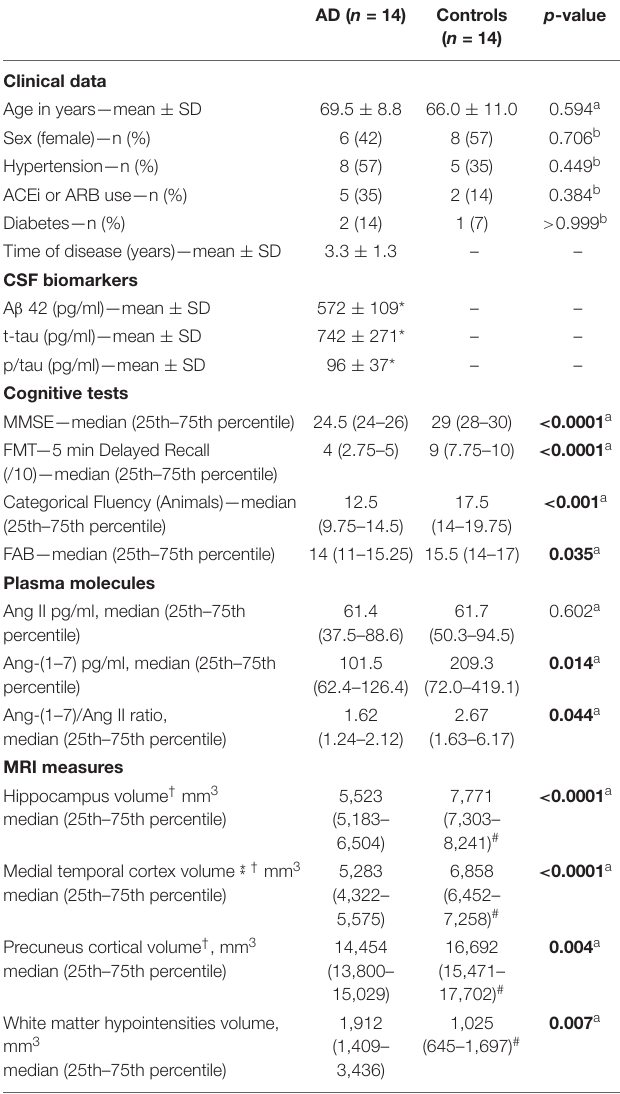
TABLE 1 | AD patients vs. controls: clinical characteristics, plasma angiotensins and neuroimaging.